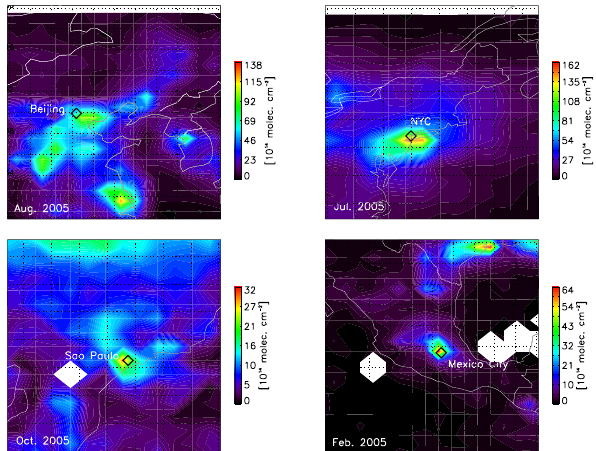
Fig. 3. The city plumes as observed in the SCIAMACHY tropo- spheric NO 2 columns for the same months as in Fig. 1. As in Fig. 1, the upper limit of the color scales has been varied to bring out the city plumes more